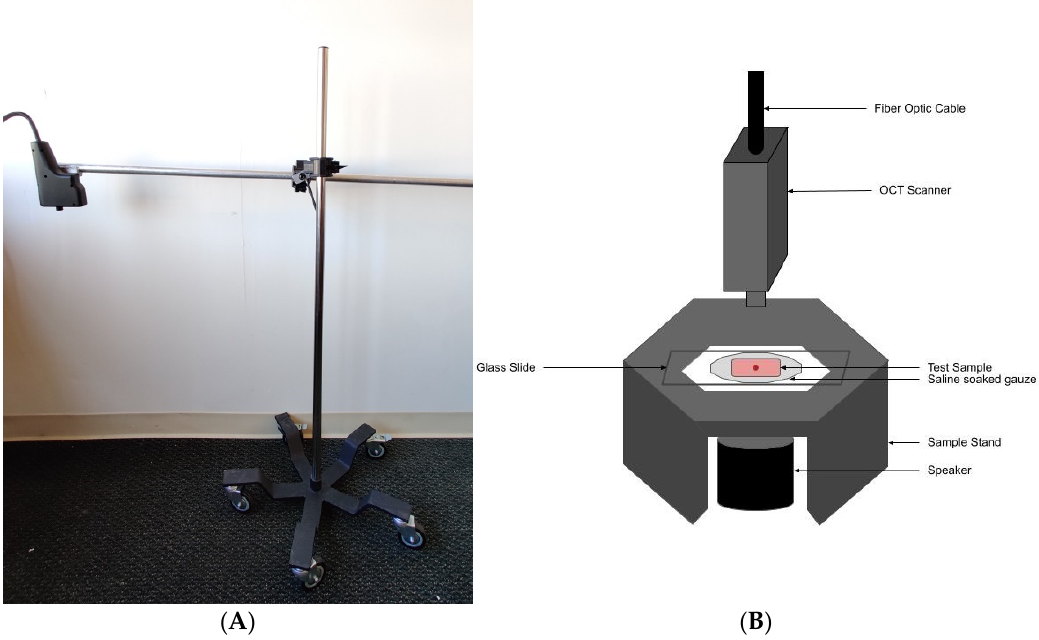
Figure 1. Picture of universal hand piece stand ( A ) used in conjunction with a table mounted speaker stand for making OCT and VOCT measurements on control skin in vivo. ( B ) Diagram of microscope stand used to mount hand piece, sample support, holder and speaker used to make OCT and vibrational OCT (VOCT) measurements on skin lesion biopsies. The blue tooth speaker is activated by an app that creates a sinusoidal signal generated by an I5 computer contained in the OCT device. The VOCT measurement of resonant frequency is made by processing the raw vibrational amplitudes as a function of time created by the sinusoidal driving signal after all out-of-phase data is filtered out. The filtering results in only elastic amplitudes being used to calculate the resonant frequency and modulus of the sample studied.